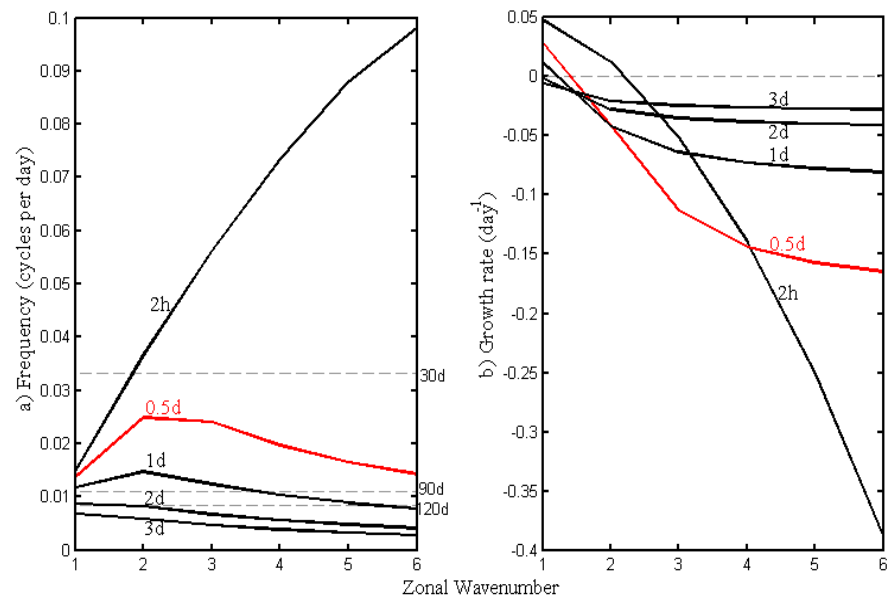
Figure 2. Sensitivity of FCDM model to different values of convective adjustment time (CAT): ( a ) frequency (cycles per day); and ( b ) growth rate (day − 1 ) as a function of wavenumber with different CAT values of 2 h, 0.5, 1, 2, and 3 days in the FCDM model.